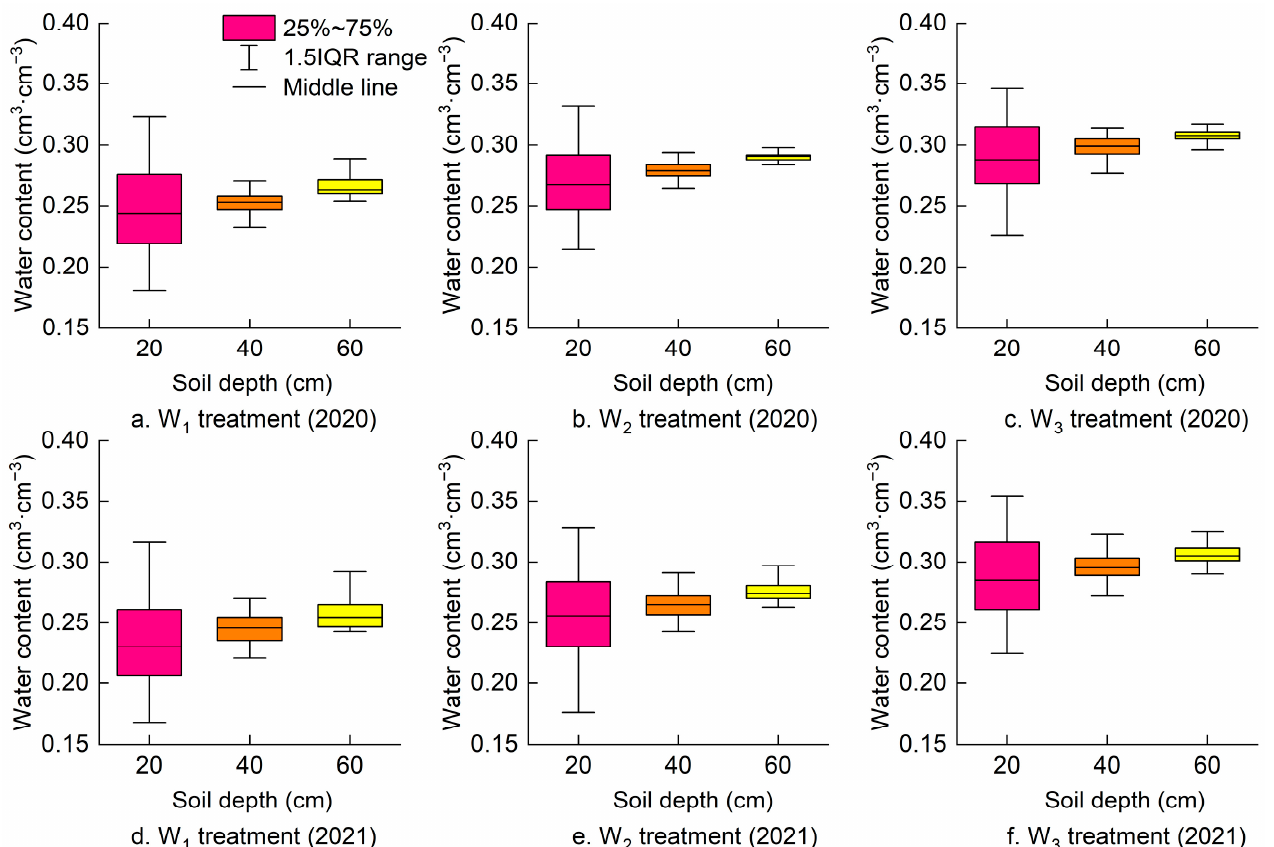
Figure 4. Soil water content ( cm 3 ·cm − 3 ) of 20 cm, 40 cm, and 60 cm soil layer under different treatments, in 2020 and 2021.